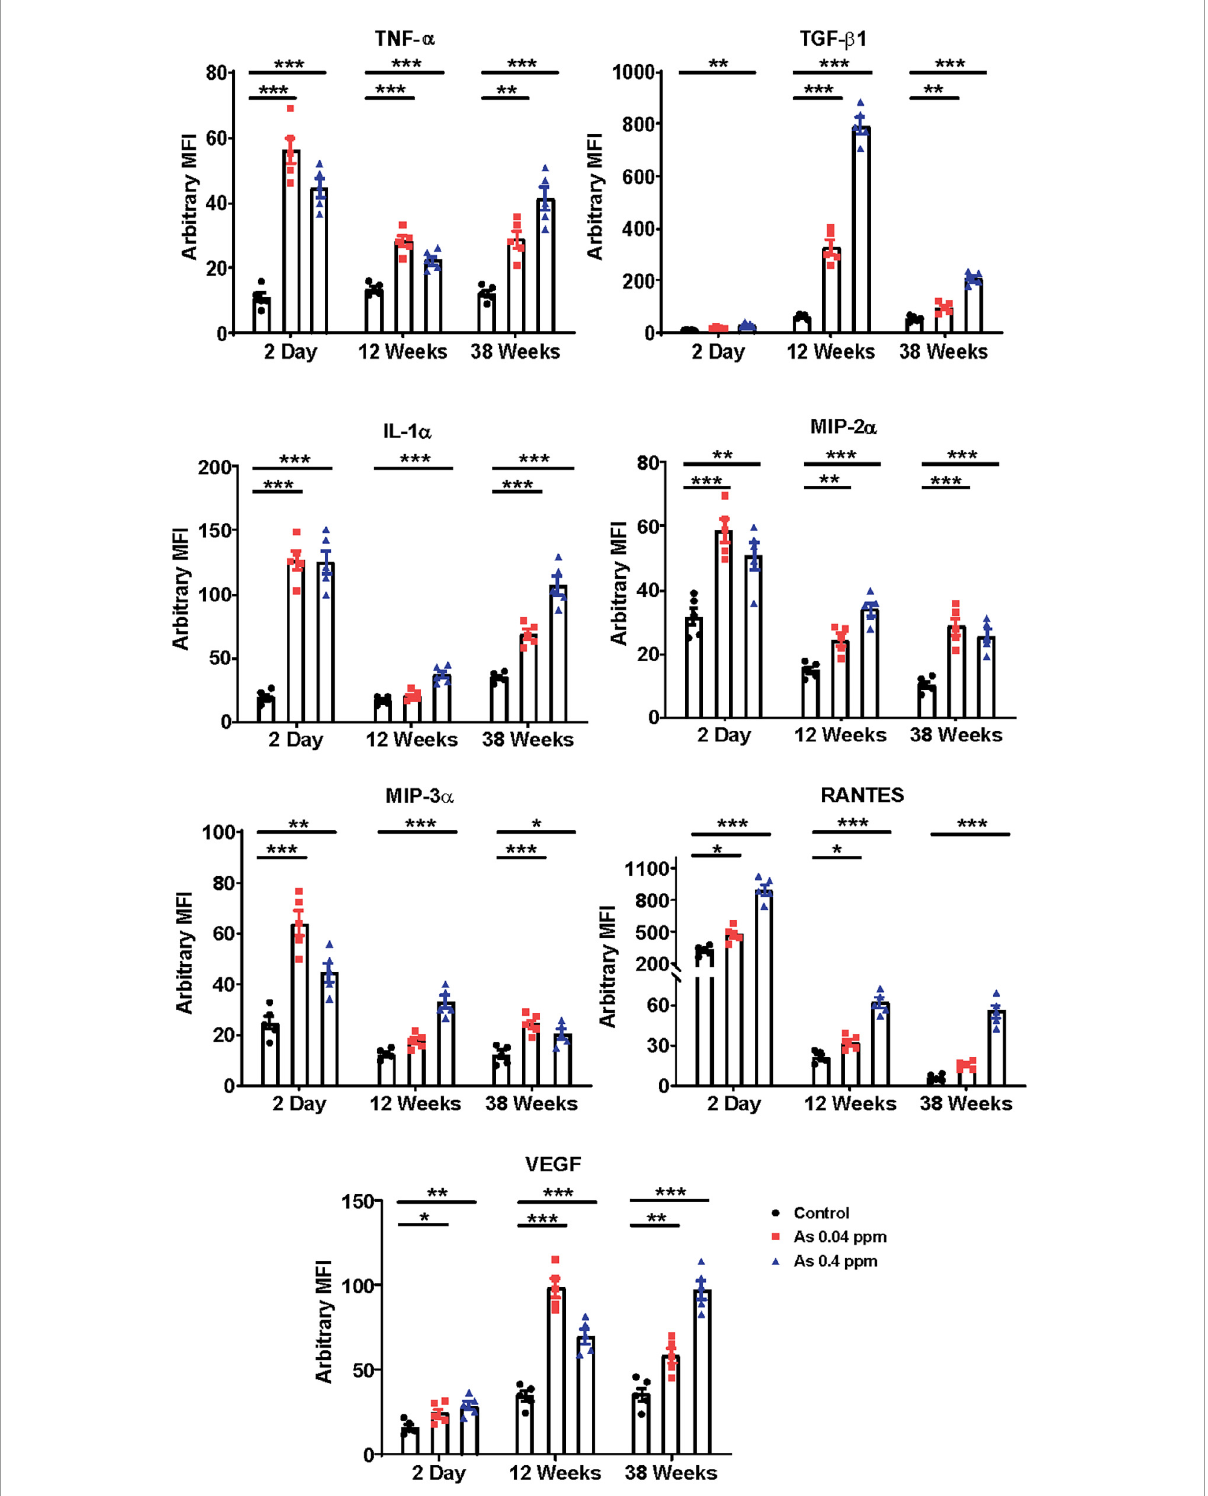
FIGURE1 Prenatal As exposure promotes the expression of proinflammatory cytokines and adipokine. Prenatal As exposure induces expression of proinflammatory cytokine and adipokines in the progeny. The level of cytokines and adipokines was assayed in blood plasma at 2 days, 12- and 38 weeks. The data is represented as mean fluorescence intensity (MFI). The data represent the mean ± SEM, n = 5 (number of experimental sets). * p < 0.05, ** p < 0.001, and *** p <